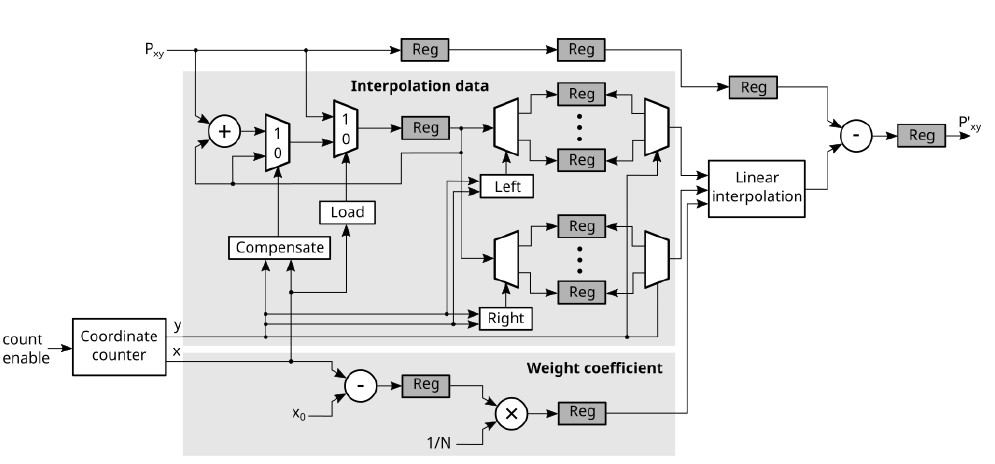
Figure 3. Temperature compensation